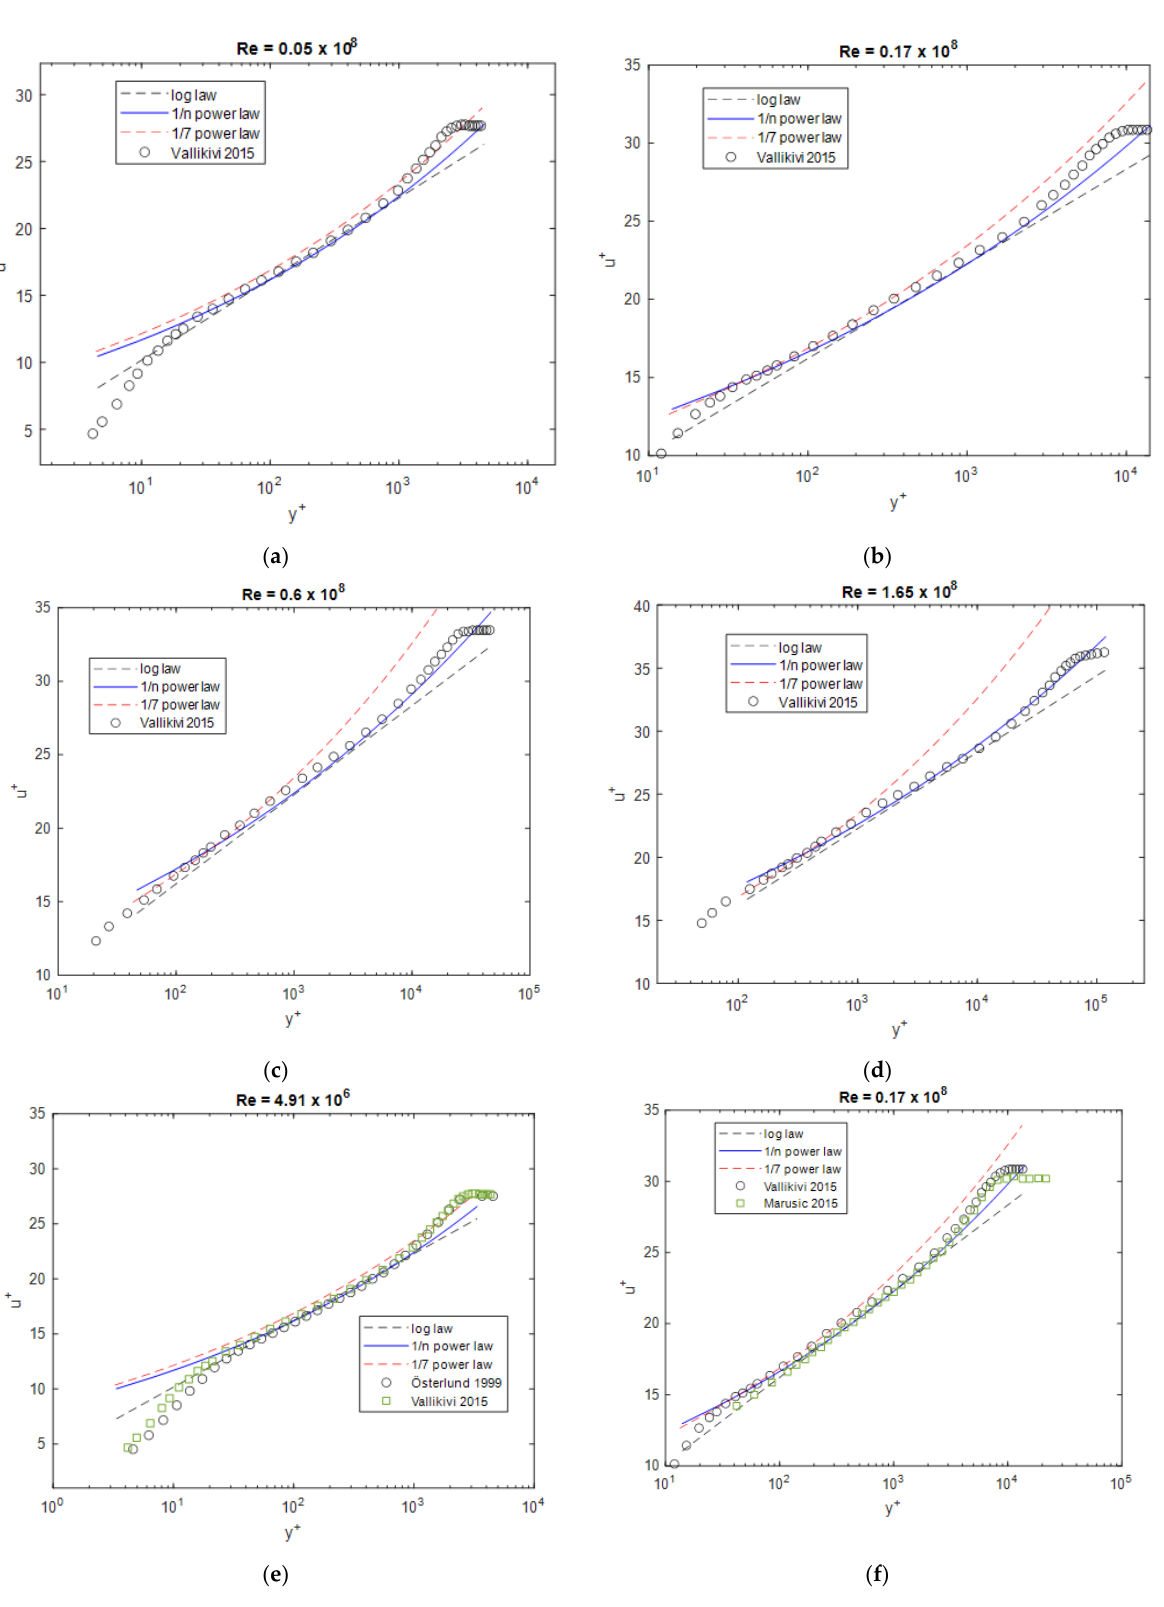
Figure 8. Boundary layer profiles at different Reynolds numbers Re x compared to the data from Vallikivi et al. [11], Marusic et al. [13], and Österlund [10], ( a ) Re = 0.05 × 10 8 , ( b ) Re = 0.17 × 10 8 , ( c ) Re = 0.6 × 10 8 , ( d ) Re = 1.65 × 10 8 , ( e ) 4.91 × 10 6 , ( f ) 0.17 × 10 8